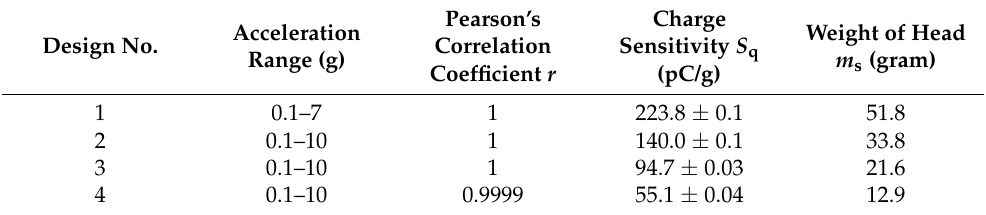
Figure 5. ( a ) Photos of accelerometer prototypes fabricated using the optimized designs (Nos. 1 to 4). ( b ) Charge versus acceleration measured for the corresponding accelerometer prototypes (test frequency = 159 Hz). ( c ) Comparison of the numerically analyzed charge sensitivity S q and an experimentally measured value. Table 3. Acceleration range, Pearson’s correlation coefficient, charge sensitivity and weight of head for the four accelerometer prototypes.